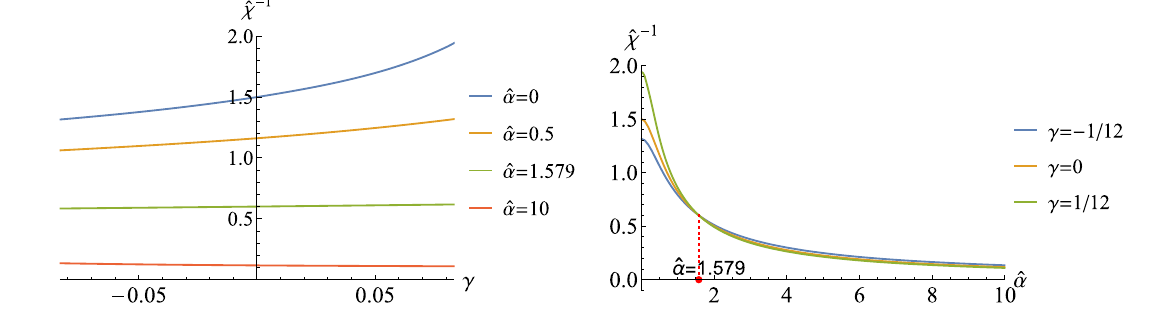
Fig. 8 Left plot: the inverse of the susceptibility ˆ χ − 1 versus the Weyl coupling parameter γ for some fixed dissipation constant ˆ α . Right plot: the inverse of the susceptibility ˆ χ − 1 versus the dissipation constant ˆ α